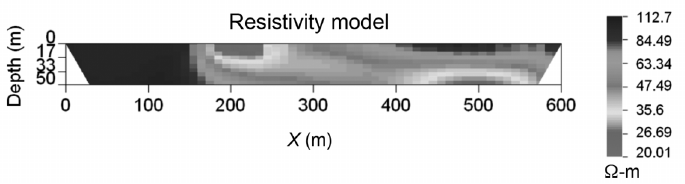
Fig. 16. Result of geophysical inversion, pdL configuration, Model 2, Scenario 1, at 700 days: recovered resis- tivity.